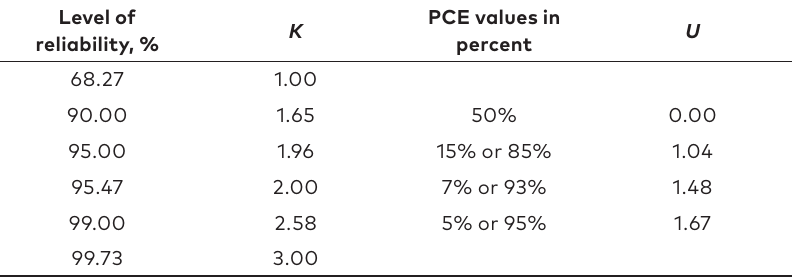
Table 2. K and U values for a certain level of reliability